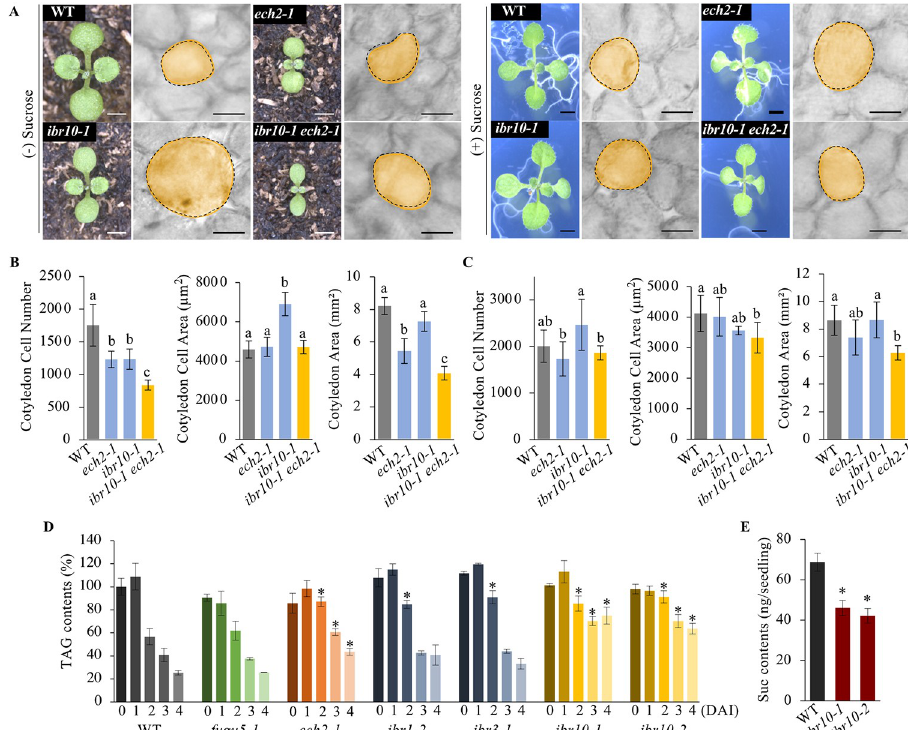
Fig 2. ibr10 Mutants Exhibit Typical Class II Compensation. (A) Seedling gross phenotypes and cotyledon cellular phenotypes. Seedling (left panels) and corresponding cotyledon palisade tissue cells (right panels) of each line grown either on rockwool or MS + 2% Suc medium, respectively. Seedling photographs were taken at 10 DAS. Bar = 5 mm. Palisade tissue cells images were taken at 25 DAS. Bar = 100 μ m. DAS, days after sowing. (B) Quantification of cotyledon cellular phenotypes. Cell number, cell area and cotyledon area were determined in cotyledons grown on rockwool (without exogenous Suc). Data are means ± SD (n = 8 cotyledons). Letters indicate groups (Tukey’s HSD test at P < 0.05; R version 3.5.1). (C) Quantification of cotyledon cellular phenotypes. Cell number, cell area and cotyledon area were determined in cotyledons grown on MS + 2% Suc medium for 25 DAS. Data are means ± SD (n = 8 cotyledons). Letters indicate groups (Tukey’s HSD test at P < 0.05; R version 3.5.1). (D) Time course analyses of TAG breakdown. Seeds of the WT and all mutant lines indicated above were surface-sterilized and sown on MS medium plates without Suc supply. TAG contents were quantified as described in “ Methods ”; 20 dry seeds or 20 etiolated seedlings were used for each measurement. Data are means ± SD (n = three independent experiments; three independent measurements per experiment). Single asterisk represents a statistically significant difference compared to the WT ( P < 0.01 by Dunnett’s test; R version 3.5.1). DAI, days after induction of seed germination. TAG, triacylglycerol. (E) Quantification of Suc contents in etiolated seedlings. 100 etiolated seedlings were collected from MS medium without Suc, and Suc contents were quantified using the internal standard methods of GC-QqQ-MS at 3 DAI. Data are means ± SD (n = five independent experiments; three independent measurements per each experiment). Single asterisk represents a statistically significant difference compared to the WT ( P < 0.05 by Dunnett’s test; R version